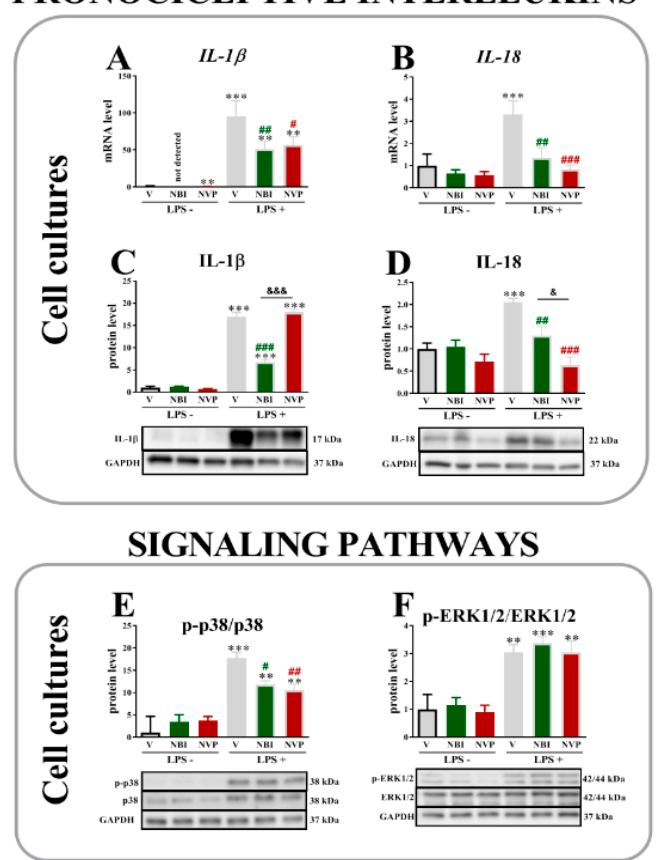
Figure 6. Comparison of the effects of (±)-NBI 74330 and NVP CXCR2 20 (100 nM; each) on the mRNA ( A , B ) and protein ( C – F ) levels of select interleukins (IL-1 β and IL-18) and signaling pathways (p38 and ERK1/2) in microglial ( A – F ) cell cultures. The RT-qPCR and Western blot data are presented as the means ± SEM (3–4 independent experiments). The results were evaluated using one-way ANOVA followed by Bonferroni’s test. ** p < 0.01 and *** p < 0.001 for the comparison of the control group (vehicle-treated nonstimulated cells) with all groups. # p < 0.05, ## p < 0.01, and ### p < 0.001 for the comparison of vehicle-treated LPS-stimulated cells with all groups. & p < 0.05 and &&& p < 0.001 for the comparison of NBI with NVP groups. Abbreviations: vehicle, V; (±)-NBI 74330, NBI; NVP CXCR2 20, NVP; lipopolysaccharide, LPS; LPS+, LPS-stimulated cells; LPS-, LPS-nonstimulated cells. Both ( ± )-NBI 74330 and NVP CXCR2 20 downregulated IL-1 β levels compared